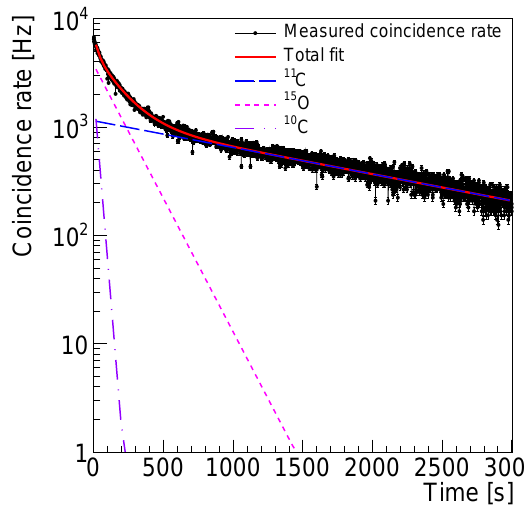
Figure 11. Time dependence of the measured coincidence rate. The exponential decay fitting function and the separate components corresponding to the activated elements are